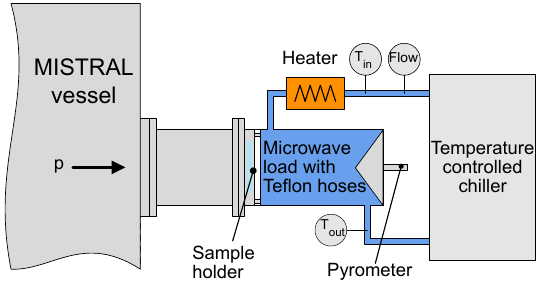
Figure 2. Caloric load attached to MISTRAL DN150 port.